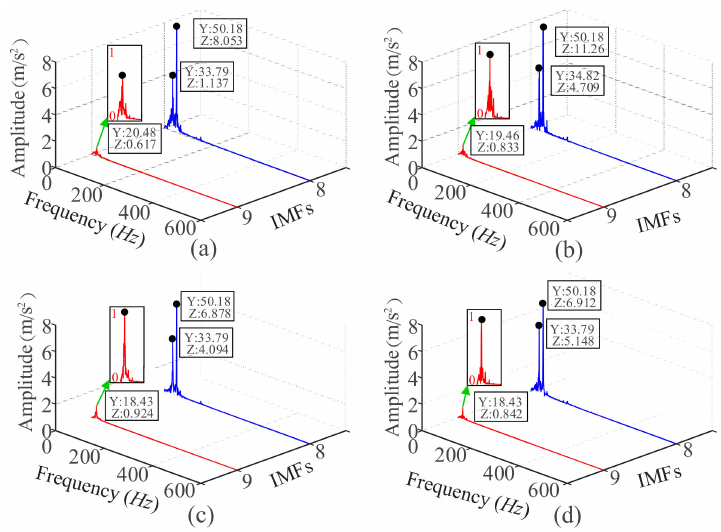
Figure 10. Frequency-domain waveform of IMF8 and IMF9; ( a – d ) represent normal valve, 2 mm leakage, 6 mm leakage, and 8 mm leakage valve,